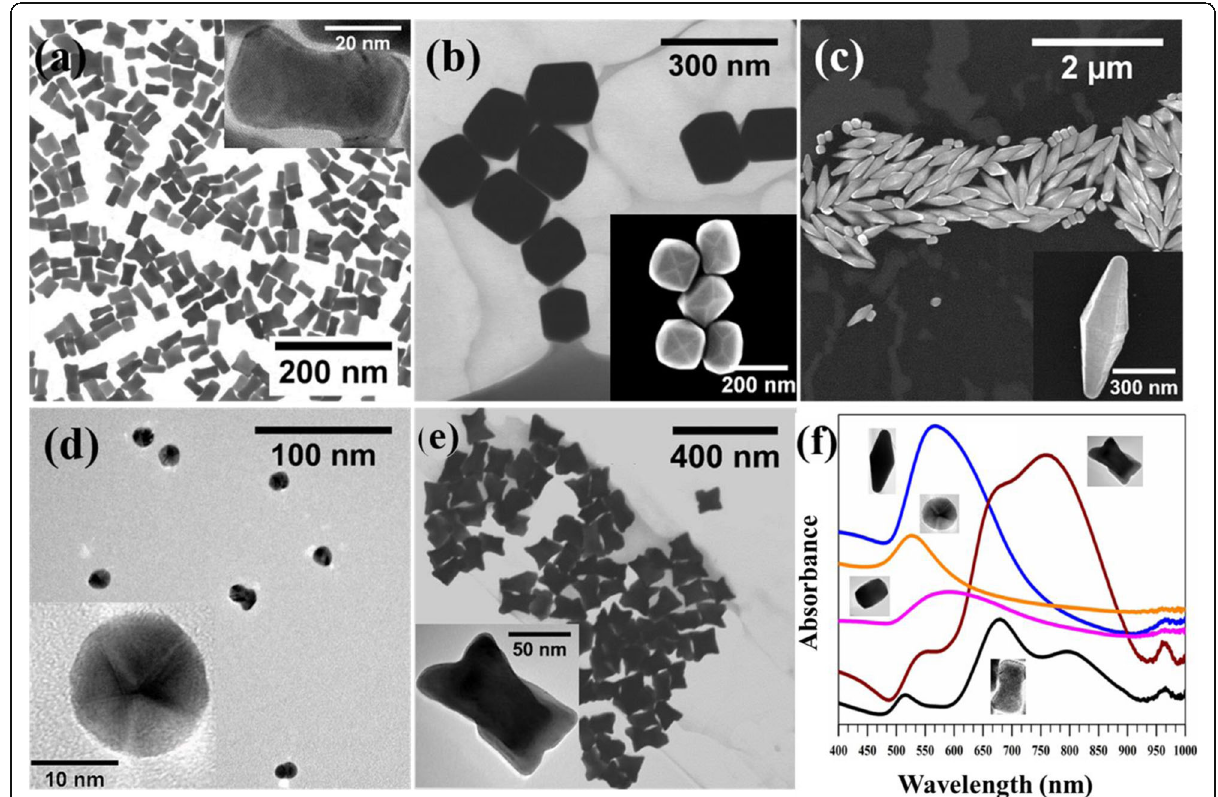
Fig. 2 STEM images and UV-Vis spectra of Au NS s of different shapes. a BF-STEM image of Au NRs of dog-bone morphology and HRTEM image in inset shows the single crystalline nature of NRs. b BF-STEM image of elongated tetrahexahedral Au NSs (inset is SEM image). c SEM image of Au BPs (inset is SEM image of single BP). d TEM image of Au spherical particles (HRTEM image in inset shows the polycrystalline nature of Au particles). e BF-STEM image of Au NMs. f UV-vis spectra of Au NSs of different